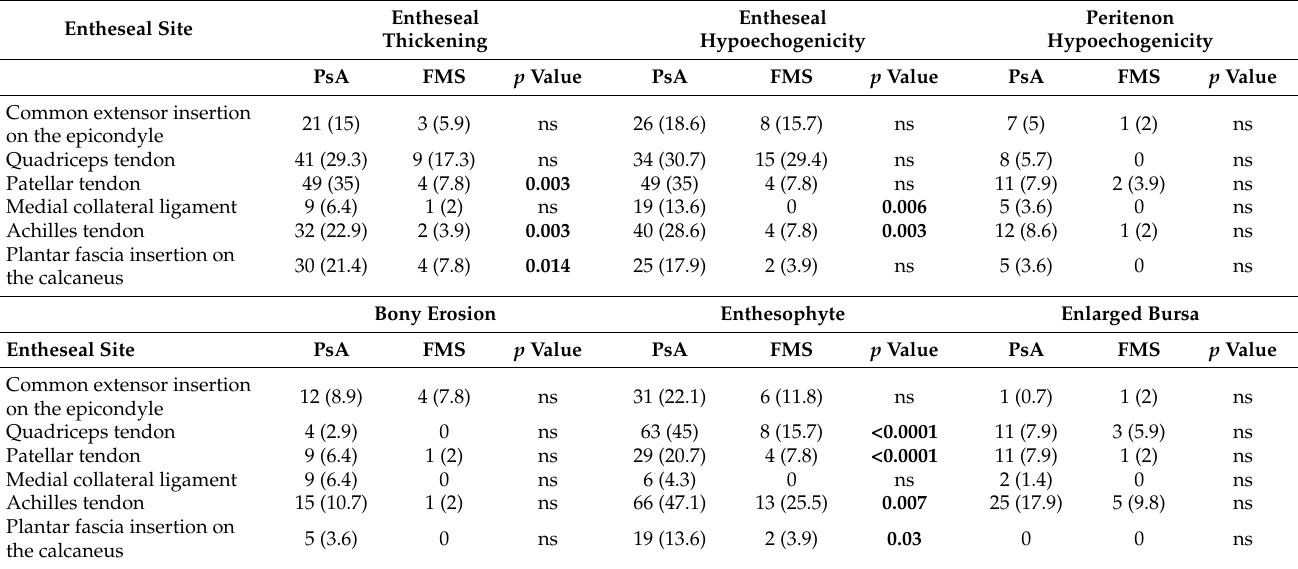
Table 5. Frequency of the various GS-US changes at the examined entheseal sites in patients with PsA ( n = 140) and those with FMS ( n =